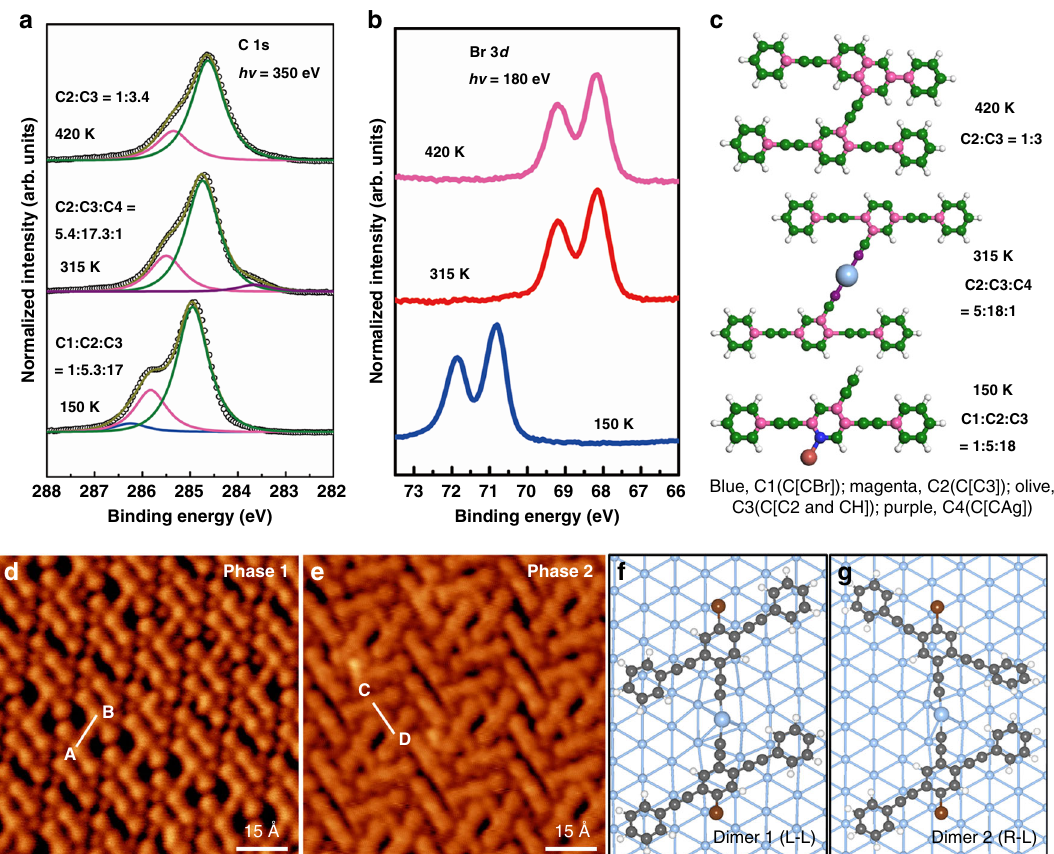
Fig. 2 SRPES of reaction products and STM of the 315 K sample. a , b C 1 s and Br 3 d SRPES of the samples prepared by depositing molecule 6 on Ag(111) held at 150 K, 315 K, annealing the 315 K sample to 420 K, respectively. The photo energies for C 1 s and Br 3 d are 350 and 180 eV, respectively. c The molecular models of the main products in each temperature points. Different carbon atoms are depicted by different colors to illustrate their chemical environments. The ideal ratios of these C atoms are shown in the right. d , e STM images showing two different ordered phases of products upon deposition of 6 on Ag(111) held at 315 K. Tunneling parameters: d V = − 2.1 V, I = − 0.3 nA; e V = − 1.5 V, I = − 0.2 nA. The center-to-center of the monomer in organometallic dimers are marked by white lines AB and CD. f , g The optimized bimolecular organometallic con fi gurations formed at 315 K. Color code: C, gray; H, white; Br, red; Ag,